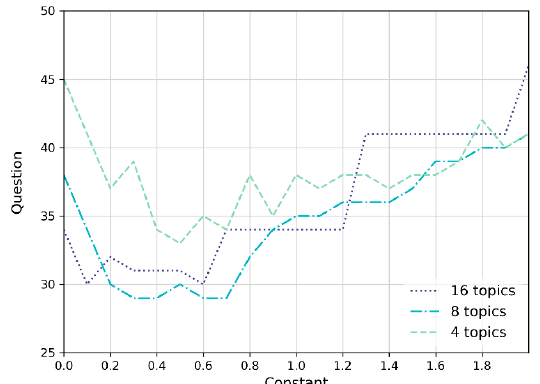
Figure 2. Number of questions needed to achieve 95% accuracy as a function of exploration constant C for 4, 8, and 16 topics and 64 questions.